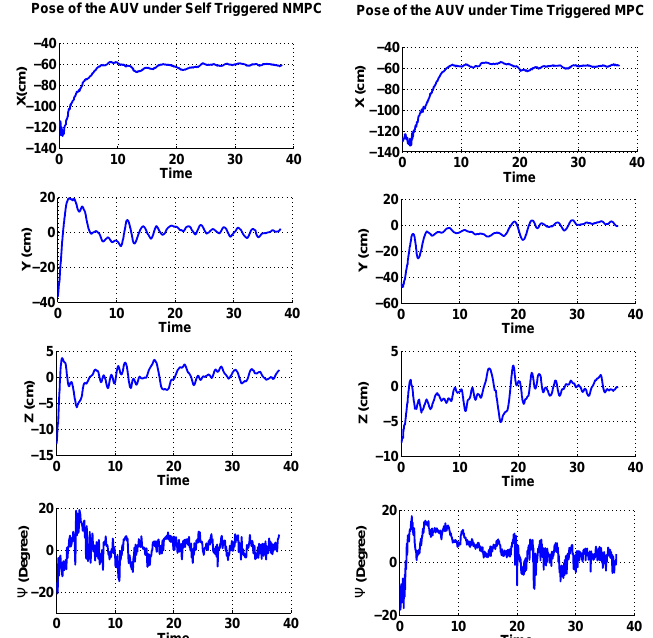
Figure 6. The evaluation of the underwater robot coordinates regarding the visual target. ( Left )